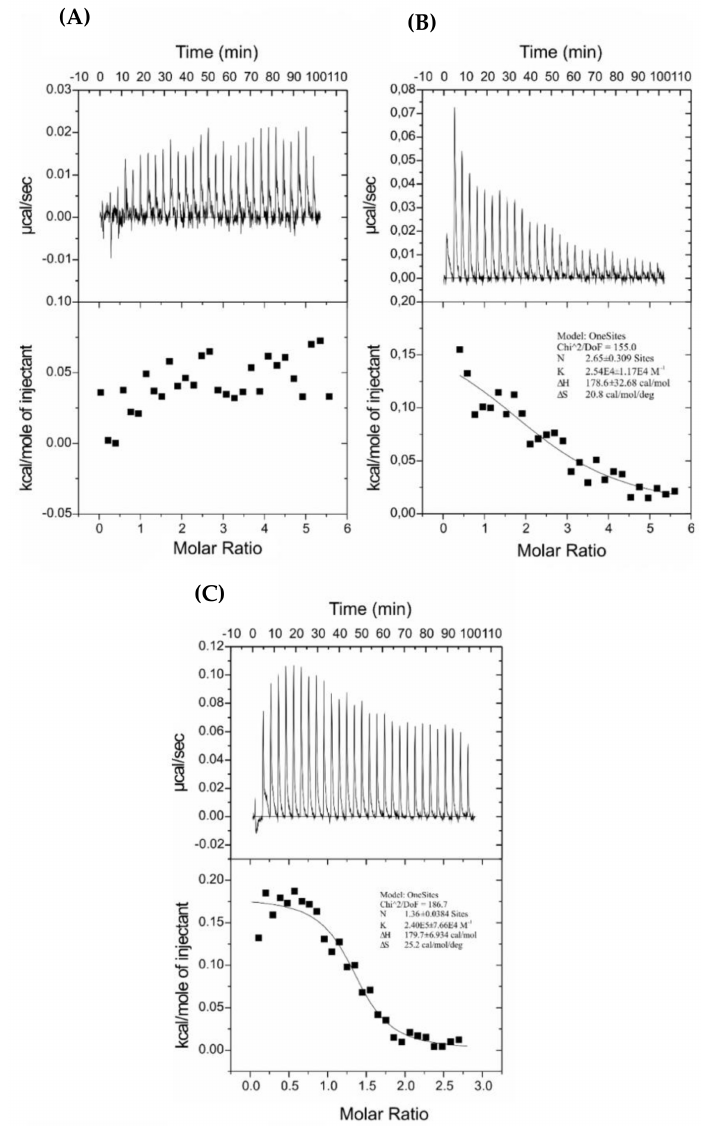
Figure 6. Isothermal calorimetric titration patterns obtained for titration of ( A ) 0.05 mM C5-DK5, lower curves represent the heat of reaction (measured by peak integration) as a function of the lipid/peptide molar